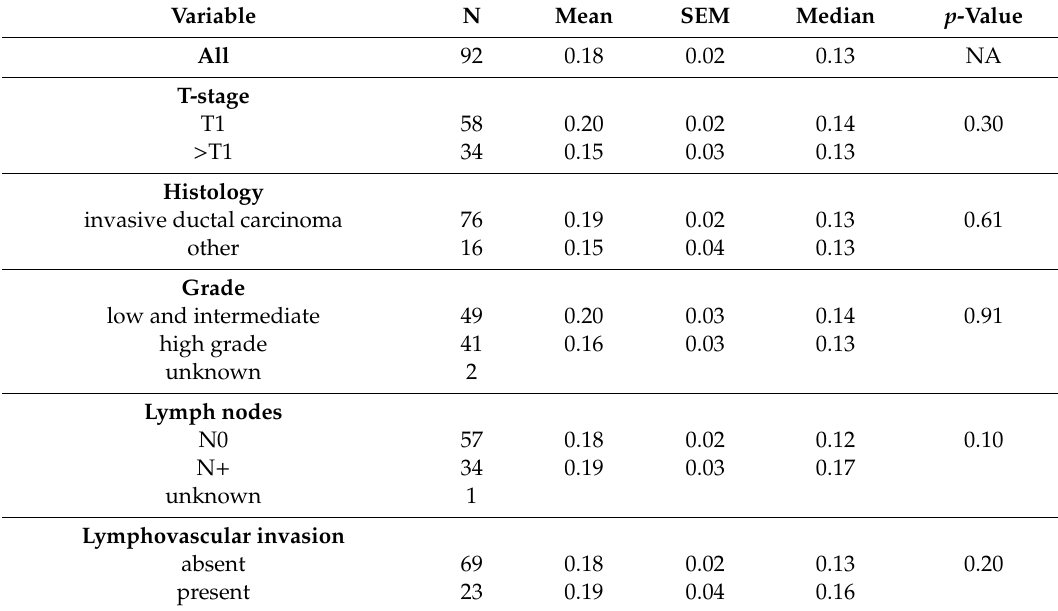
Table 2. Association between nucleosomes and patient / tumor